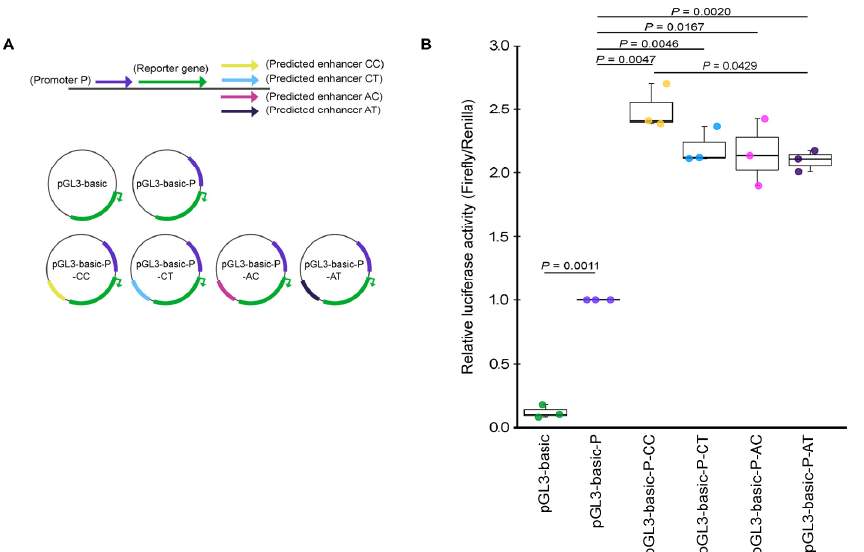
Figure 4. Relative luciferase activity for the human CYP26B1 promoter and predicted enhancer containing different haplotype of SNPs rs12713768 and rs10208040 in HEK293T cells. ( A ) Different constructs design to evaluate the functionality of promoter and predicted enhancer of different haplotype variants. ( B ) Luciferase activities increased by 2.0-fold with the presence of the predicted enhancer, pGL3-basic-P-CT, pGL3-basic-P-AC, and pGL3-basic-P-AT, as well as by 2.5-fold with the presence of pGL3-basic-P-CC. The presence of risk-conferring CC haplotype within the predicted enhancer (pGL3-basic-P-CC) caused an 18.9% increase in activity ( p -value = 0.0429) compared with pGL3-basic-P-AT. N = 3 independent experiments. Each dot represents the average of four independent biological replicates of each luciferase assay. Statistical significance changes in reporter gene activity were calculated by the unpaired two-tailed Student’s t -test.